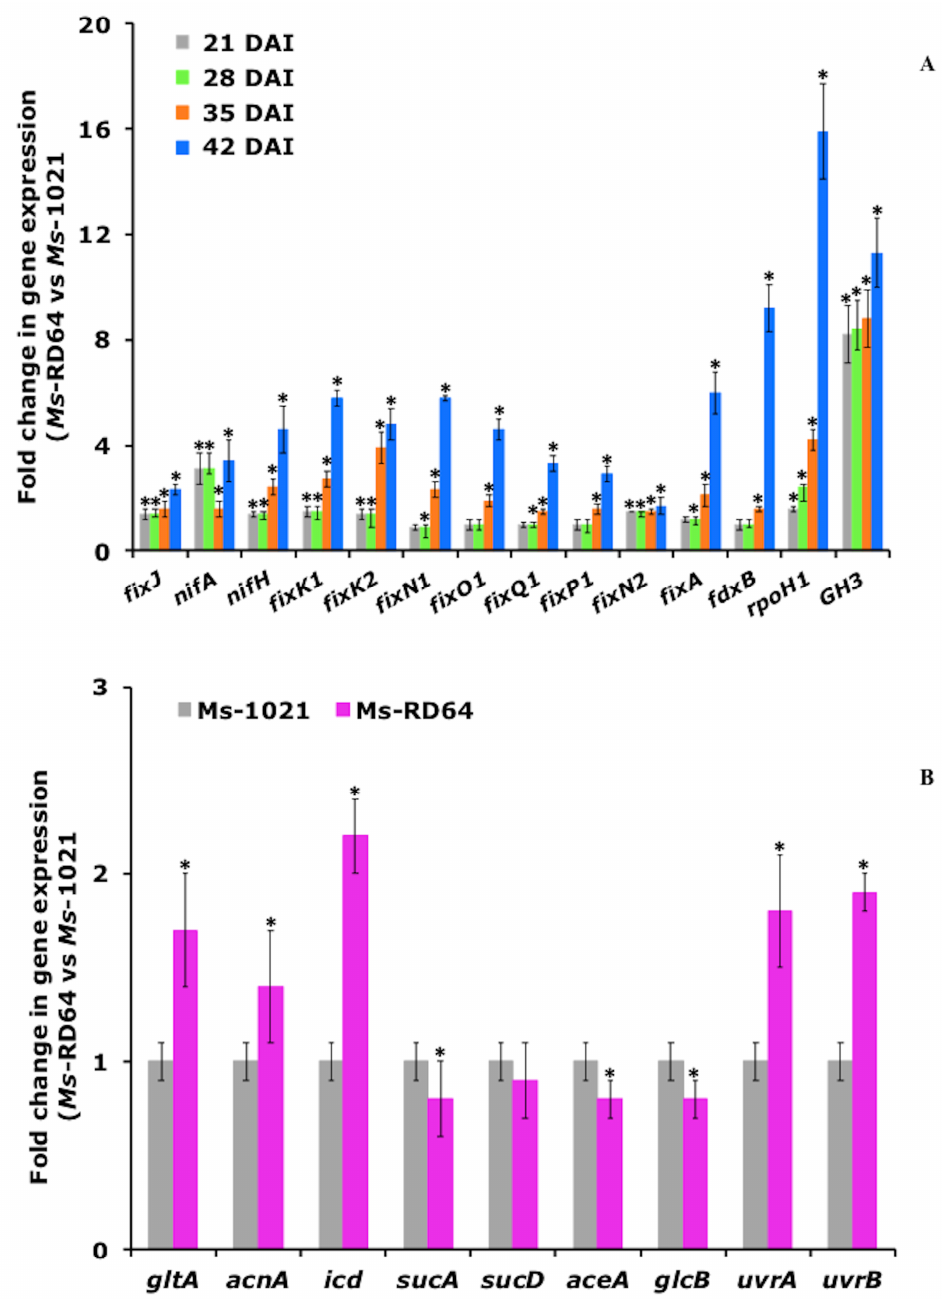
Figure 1. The expression of genes involved in nitrogen-fixation, energy metabolism, stress response, and genetic information processing increased in Medicago plants nodulated by Ensifer meliloti RD64. ( A ) Quantitative measurement of transcript levels for nitrogen-fixation genes, rpoH1 and GH3 , in root nodules of Medicago plants nodulated by the strains E. meliloti RD64 and 1021 at 28, 21, 35, or 42 days after infection (DAI). ( B ) Quantitative measurement of transcript levels for energy metabolism and DNA repair genes in root nodules of Medicago plants nodulated by the strains E. meliloti RD64 and 1021 at 42 DAI. Fold change >1: genes more highly expressed in Medicago plants nodulated by RD64; fold change <1: genes more highly expressed in Medicago plants nodulated by 1021. Values are the means ± standard deviation (SD) of four different biological replicates. The asterisks indicate significant di ff erences ( P < 0.05, one-way ANOVA with Tukey’s post-hoc test) between 1021- and RD64-nodulated